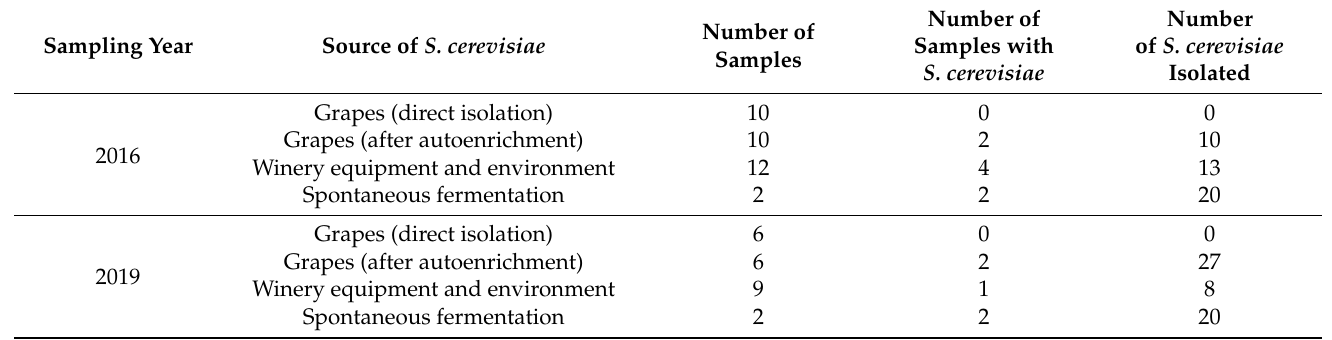
Table 1. Source and number of S. cerevisiae isolates during 2016 and 2019